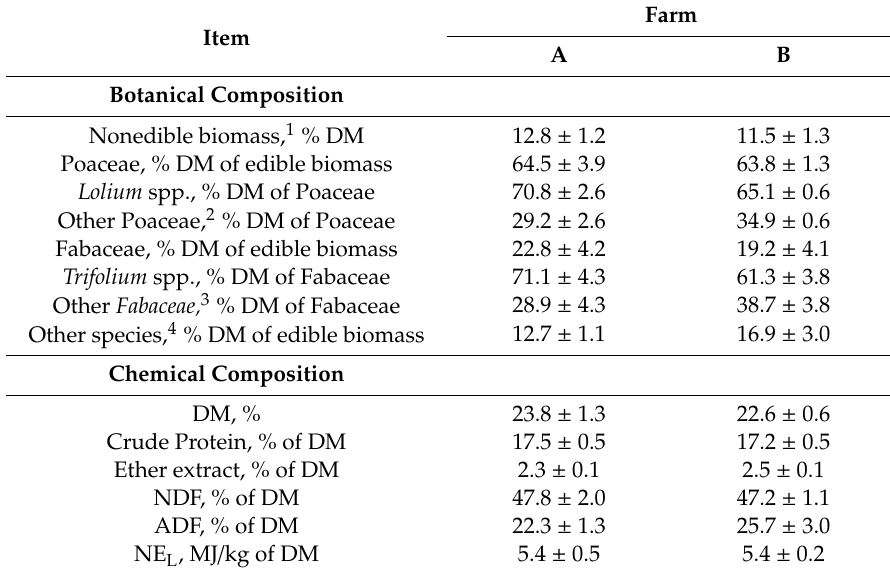
Table 3. Botanical and chemical compositions of pasture samples (raw means ±